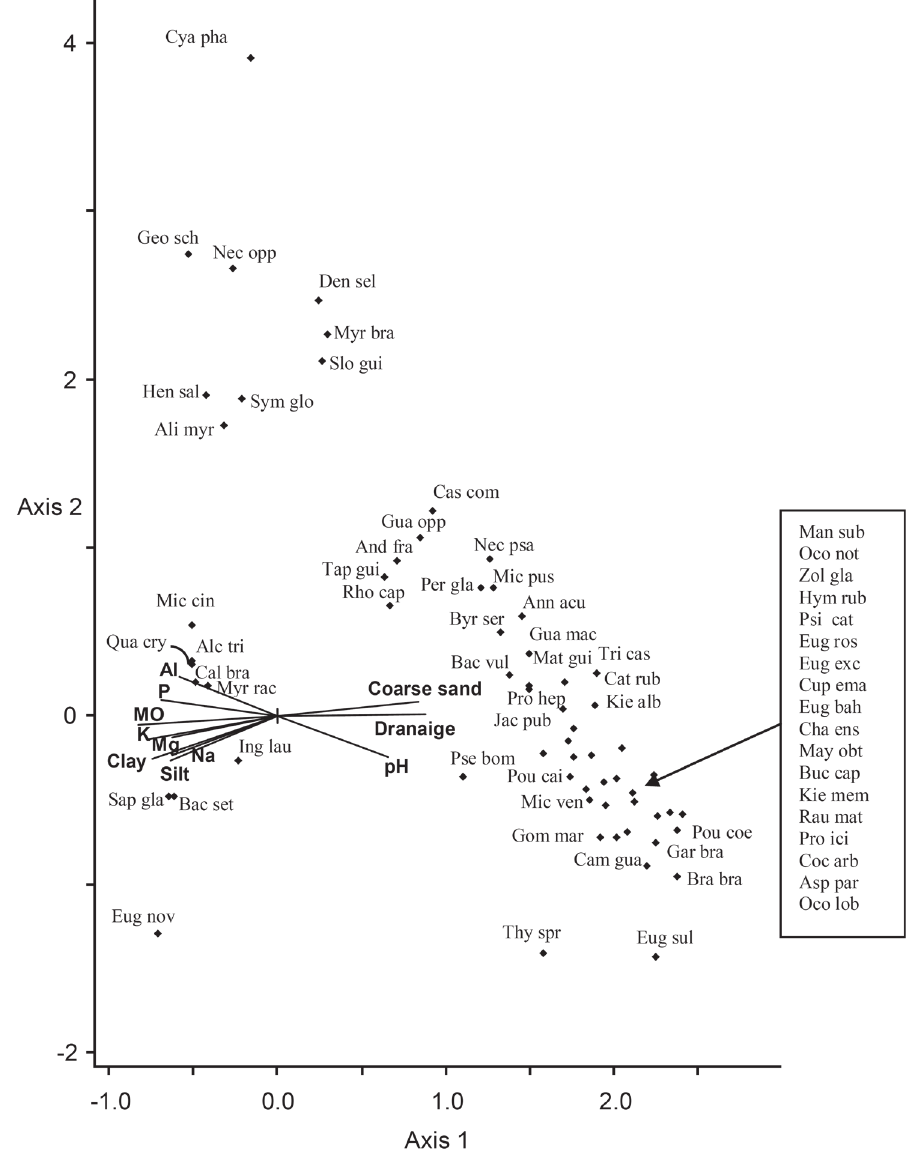
Figure 5 - Canonical Correspondence Analysis of species with the chemical soil features (CCA). Species names are listed in Table IV. pH=acidity in water, Na=sodium, Mg=Magnesium, k=Potassium, P=Phosphorus; Al=Aluminum; MO=Organic